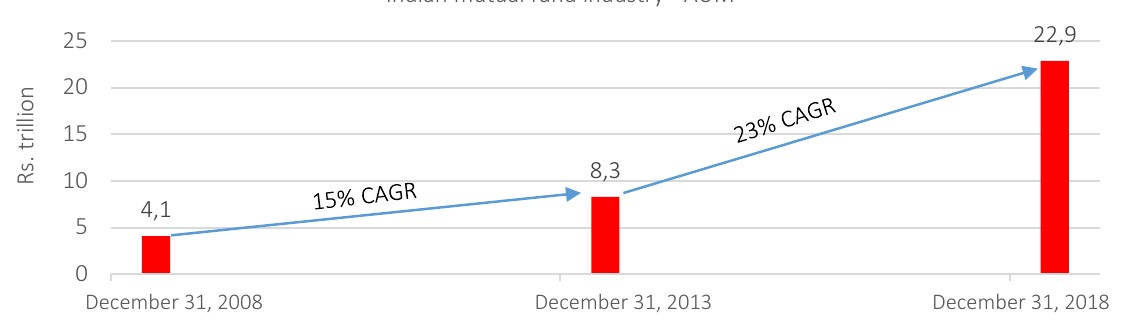
Figure 1. Indian mutual fund industry – assets under management